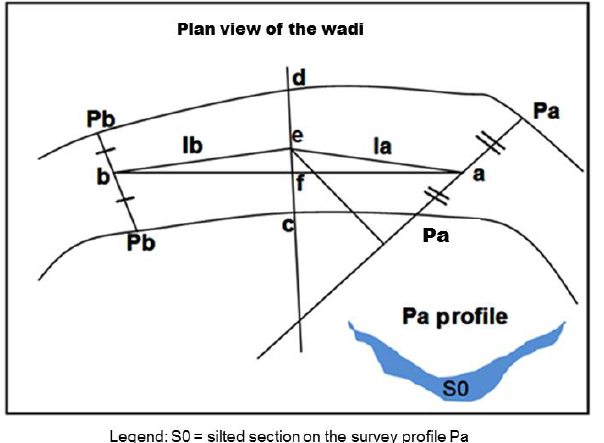
Figure 3. Diagram illustrating the General Method for estimating sedimentation volume. A plan view is shown in the upper part and a cross-section profile view is shown in the bottom right hand